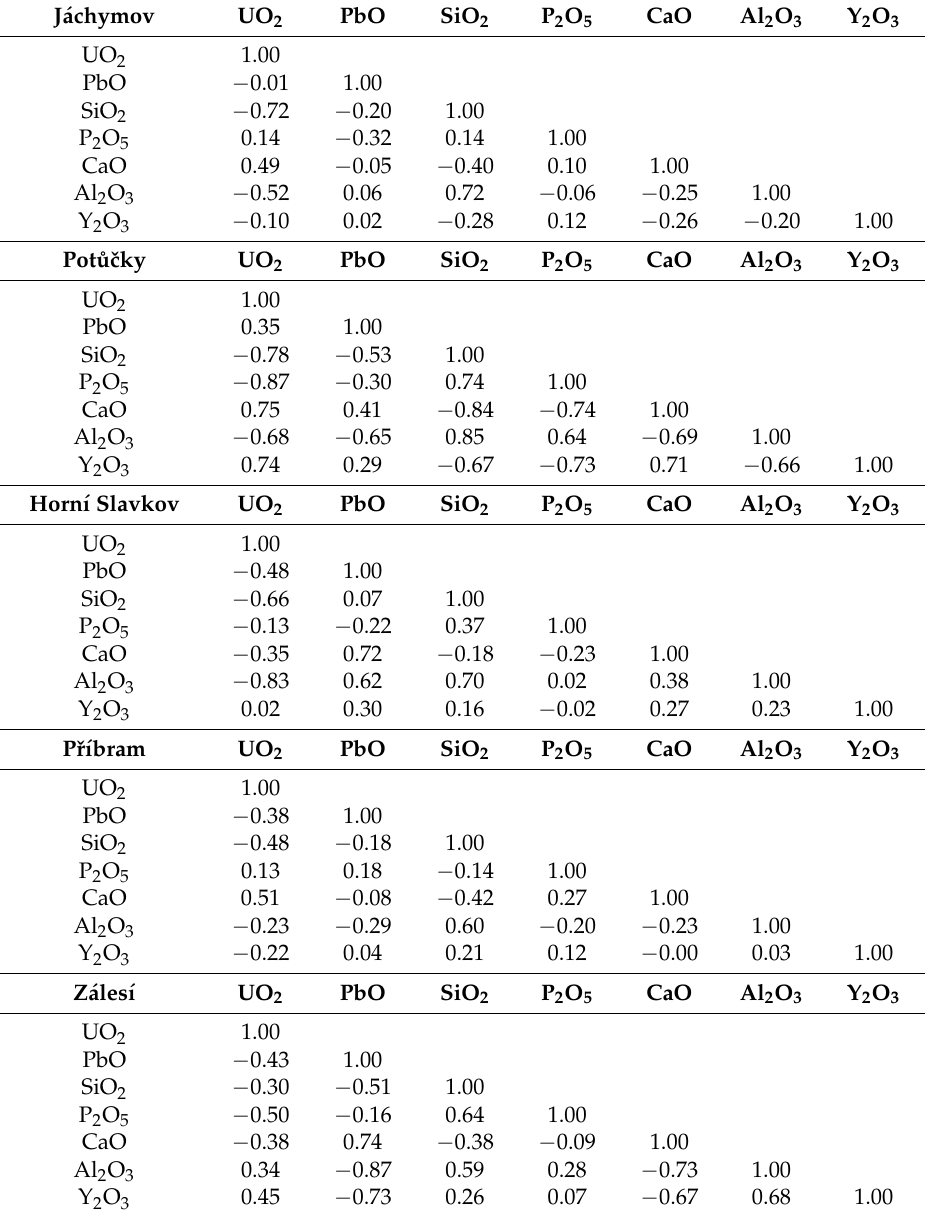
Table 4. Spearman correlation coefficients for selected elements analyzed in